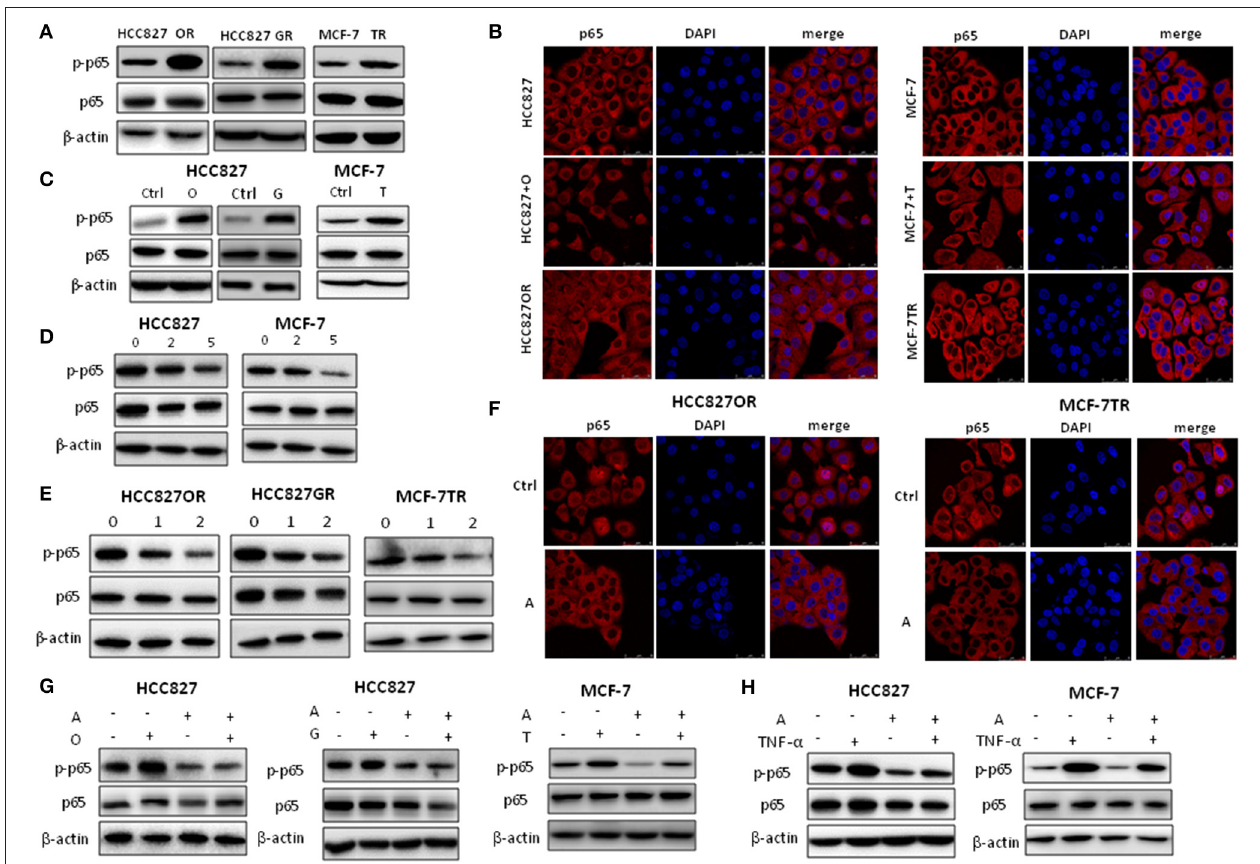
FIGURE 5 | Aspirin suppressed NF- κ B activity in cancer cells. (A) Western blot analysis of p-NF- κ B p65 (p-p65) and NF- κ B p65 (p65) in HCC827, HCC827OR (OR), HCC827GR (GR), MCF-7 and MCF-7TR (TR) cells. (B) Immunofluorescence staining analysis of p65 in HCC827, HCC827OR, or HCC827 cells treated with 10nM O for 72h (left panels) and in MCF-7, MCF-7TR, or MCF-7 cells treated with 2 µ M T for 72h (right panels). (C) Western blot analysis of p-p65 and p65 in HCC827 cells treated with 10nM O or 10nM G for 72h (left panels) and in MCF-7 cells treated with 2 µ M T for 72h. (D) Western blot analysis of p-p65 and p65 in HCC827 and MCF-7 cells treated with indicated concentration (mM) of aspirin for 72h. (E) Western blot analysis of p-p65 and p65 in HCC827OR, HCC827GR, and MCF-7TR cells treated with indicated concentration (mM) of aspirin for 72h. (F) Immunofluorescence staining analysis of p65 in HCC827OR or MCF-7TR cells treated with 1mM A for 72h. Nuclei were observed with DAPI staining. Scale bar, 50 µ m. (G) Western blot analysis of p-p65 and p65 in HCC827 or MCF-7 cells pretreated with A (2mM) for 2h and then subjected to 10nM O, 10nM G, or 2 µ M T as indicated for 72h. (H) Western blot analysis of p-p65 and p65 in HCC827 or MCF-7 cells pretreated with 2mM A for 70h and then subjected to 10ng/ml TNF- α as indicated for 2h. β -actin was used as loading